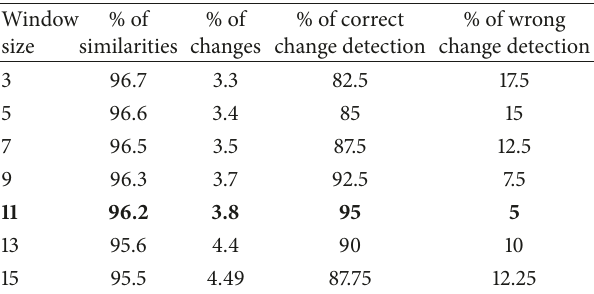
Figure 4: Relationship between window sizes and (%) of correct changes. Table 3: Percentage of changes using SWB-NMI for different window sizes (2nd dataset).